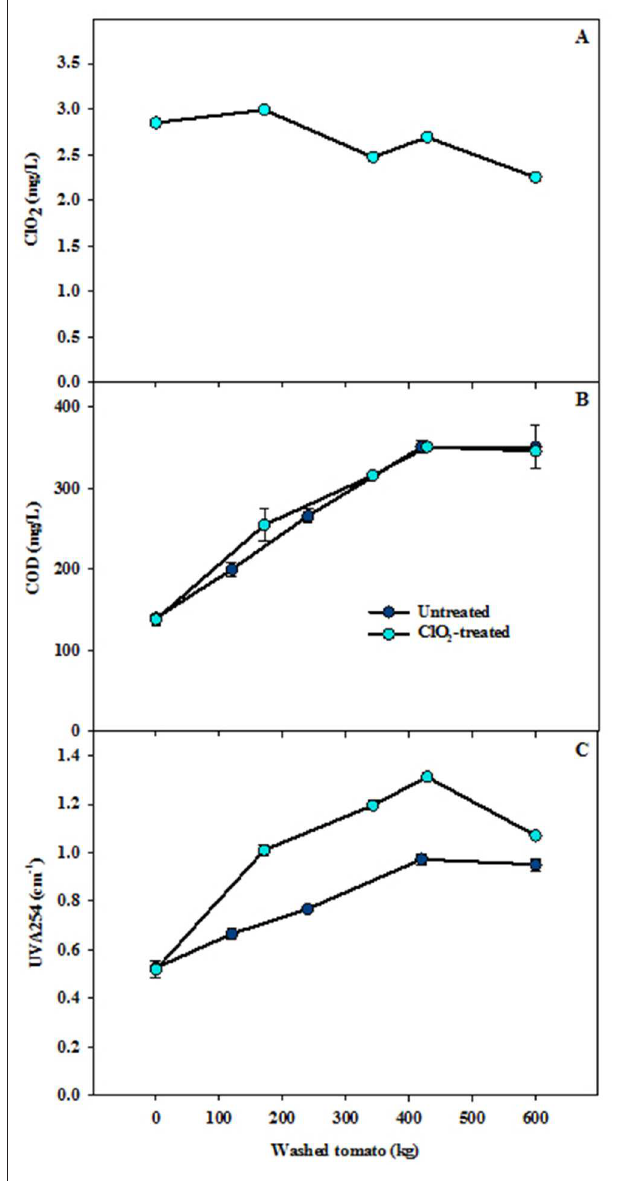
FIGURE 2 | (A) Concentration of ClO 2 in the test performed with treated recirculated water (3rd test). (B) Chemical oxygen demand (COD) in the tests performed with untreated (2nd test) and ClO 2 − treated recirculated water (3rd test). (C) Absorbance at 254nm (UVA254) in the tests performed with untreated (2nd test) and ClO 2 − treated recirculated water (3rd